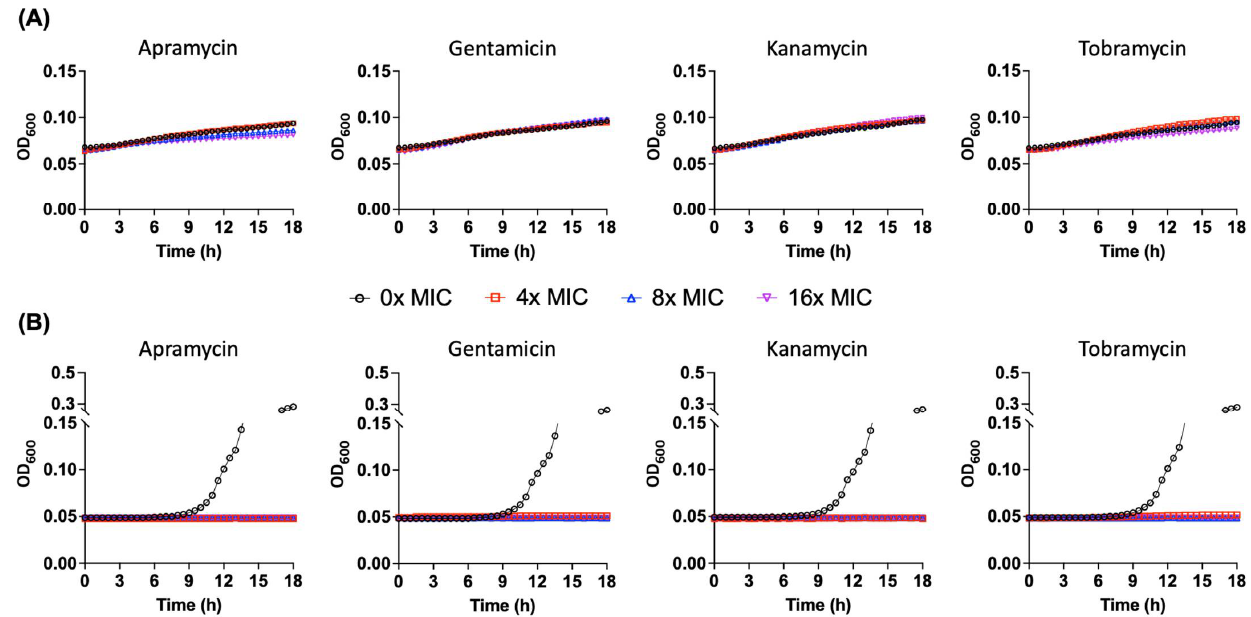
Figure 5. Survivors of Pseudomonas sp. B14-6 after treatment with gentamicin are capable of slowly replicating in bactericidal concentrations of aminoglycosides. Pseudomonas sp. B14-6 overnight culture was treated with 25 µg/mL gentamicin ( A ) or non-treated ( B ) for 18 h at 25 °C. After washing, ~10 4 CFU/mL of remaining cells were treated with the indicated concentrations of aminoglycosides for 24 h at 25 °C. Bacterial growth was evaluated by absorbance measurement at 600 nm using a plate reader. Results are shown as mean ( n = 3). The error bars are not shown for clarity.